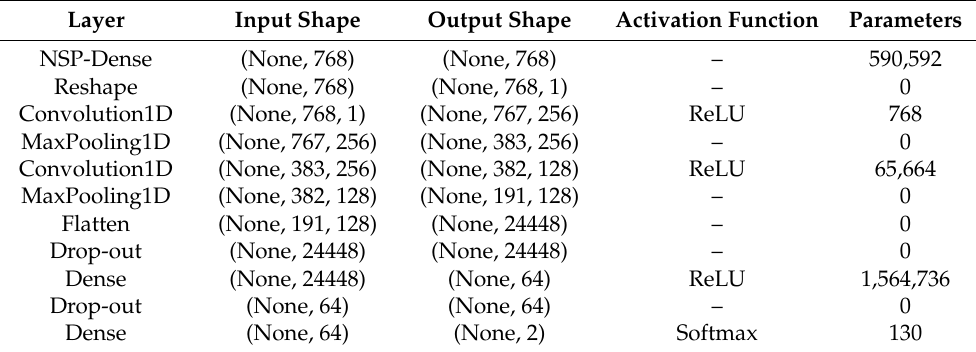
Table 1. Optimal architecture for ClaimsBERT